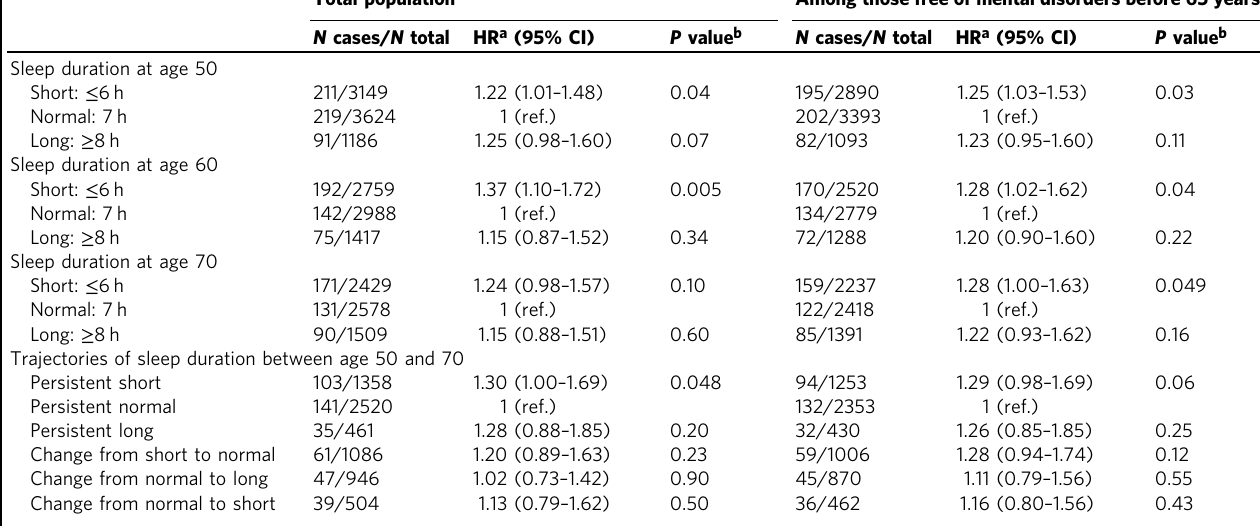
Table 5 Association between sleep duration and dementia: analysis restricted to participants without mental disorders before 65 years. Total population Among those free of mental disorders before 65 years N cases/ N total HR a (95% CI) P value b